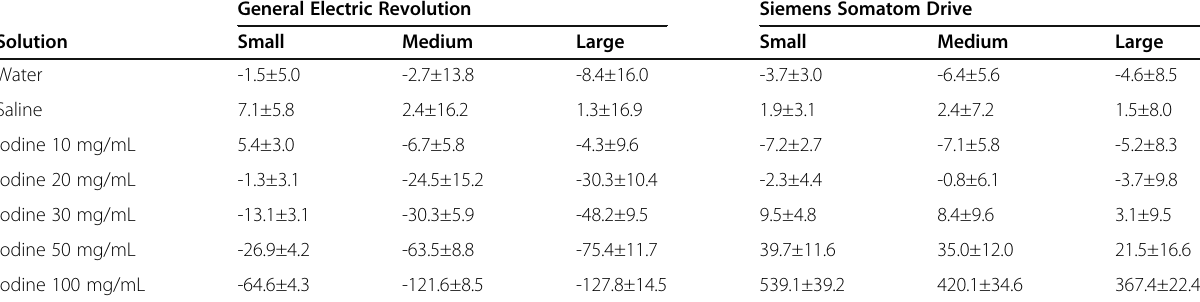
Table 3 HU and standard deviation (SD) in virtual non-contrast enhanced images for all concentrations and different phantom sizes General Electric Revolution